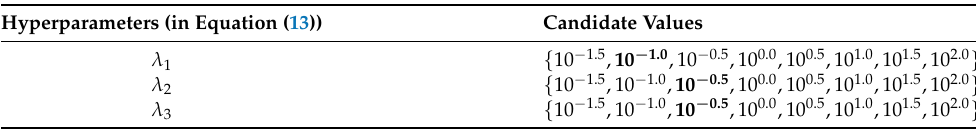
Table 5. Candidate values for tuning the hyperparameters. The numbers in bold font indicate the optimal combination in this example.